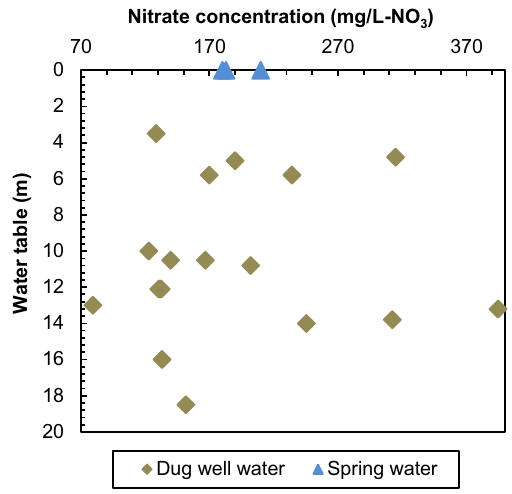
Fig. 3 NO 3− versus water table of the water samples in the study